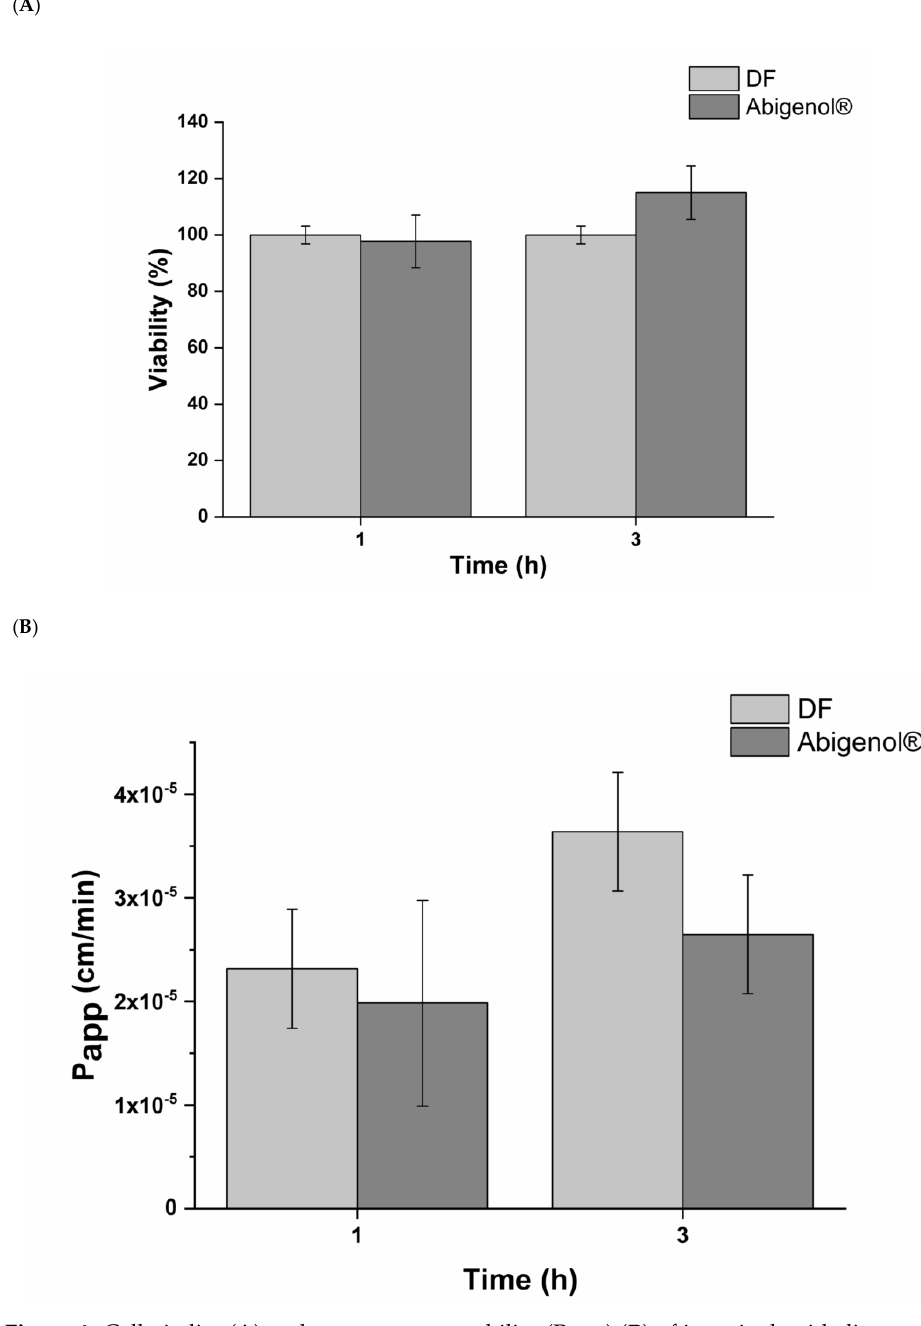
Figure 4. Cell vitality ( A ) and apparent permeability (Papp) ( B ) of intestinal epithelia exposed to digestive fluids (DF; control) and digested Abigenol ® /AlbiPhenol ® (n =